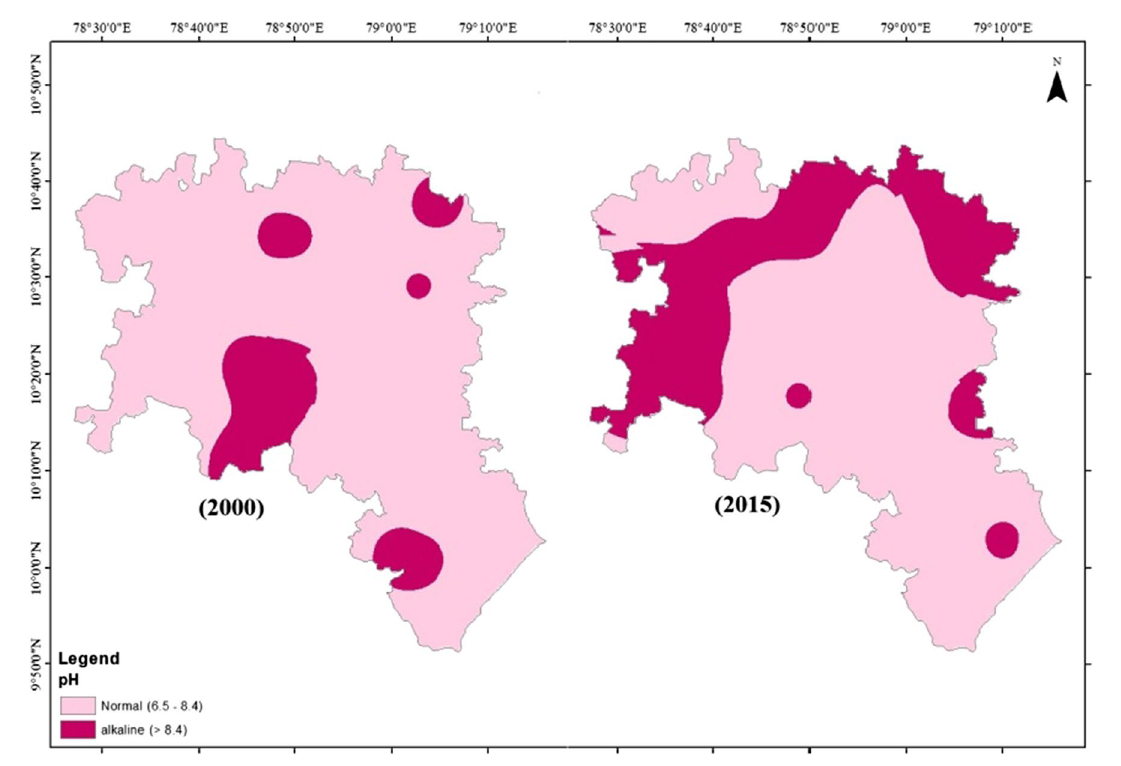
Fig. 3 Spatial distribution of pH (2000 and